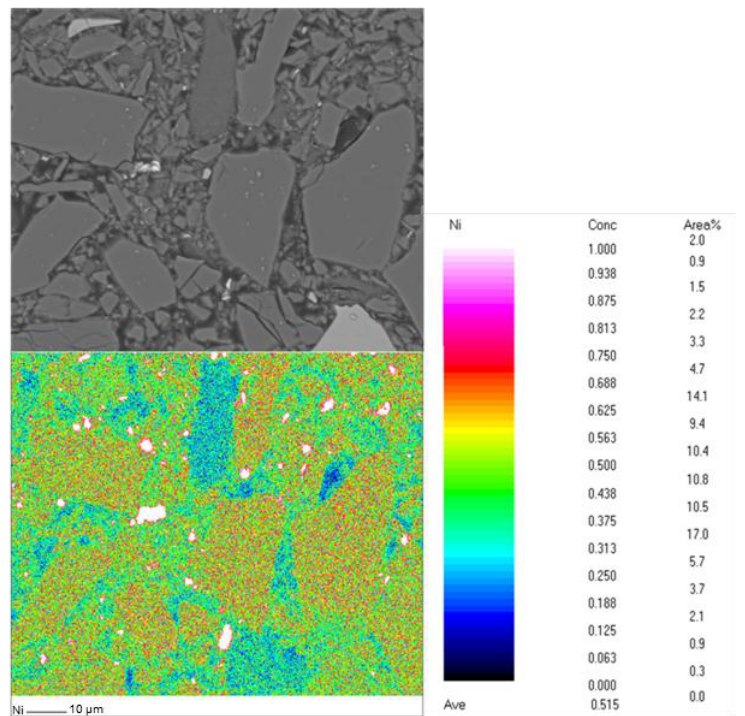
Figure 2. Fresh olivine backscattered scanning electron image ( top ) and EPMA mapping of nickel concentrations ( bottom ); concentration scale is relative to max/min